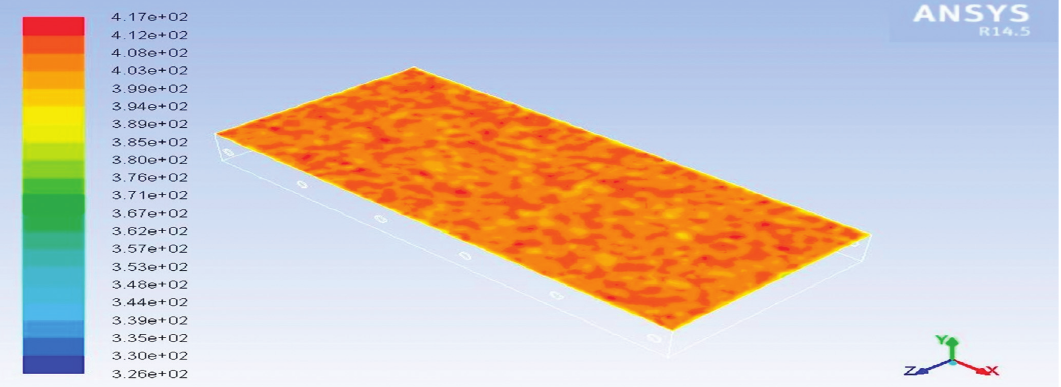
Figure 14: Effect of glass temperature at the afternoon time.